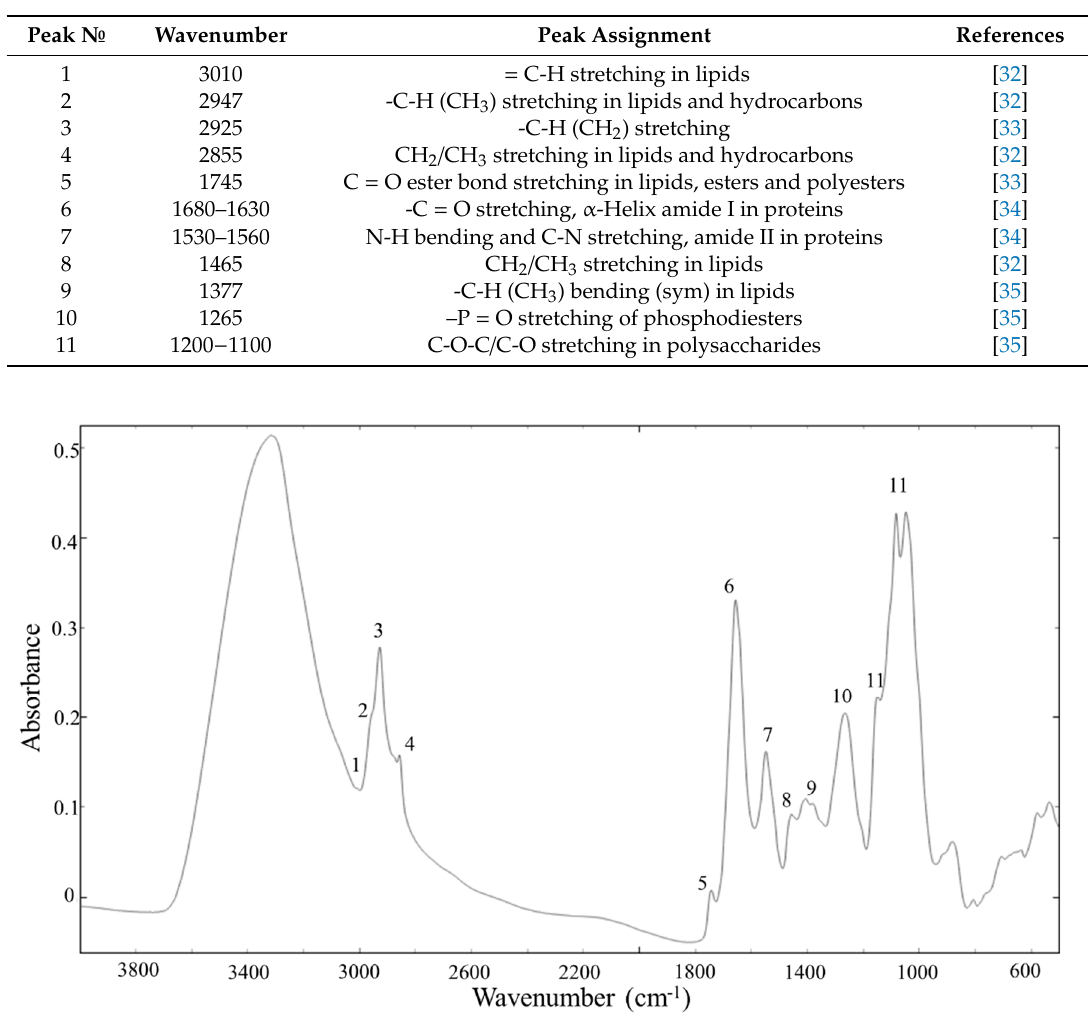
Table 4. Peaks assignment for the FTIR spectra of yeast.